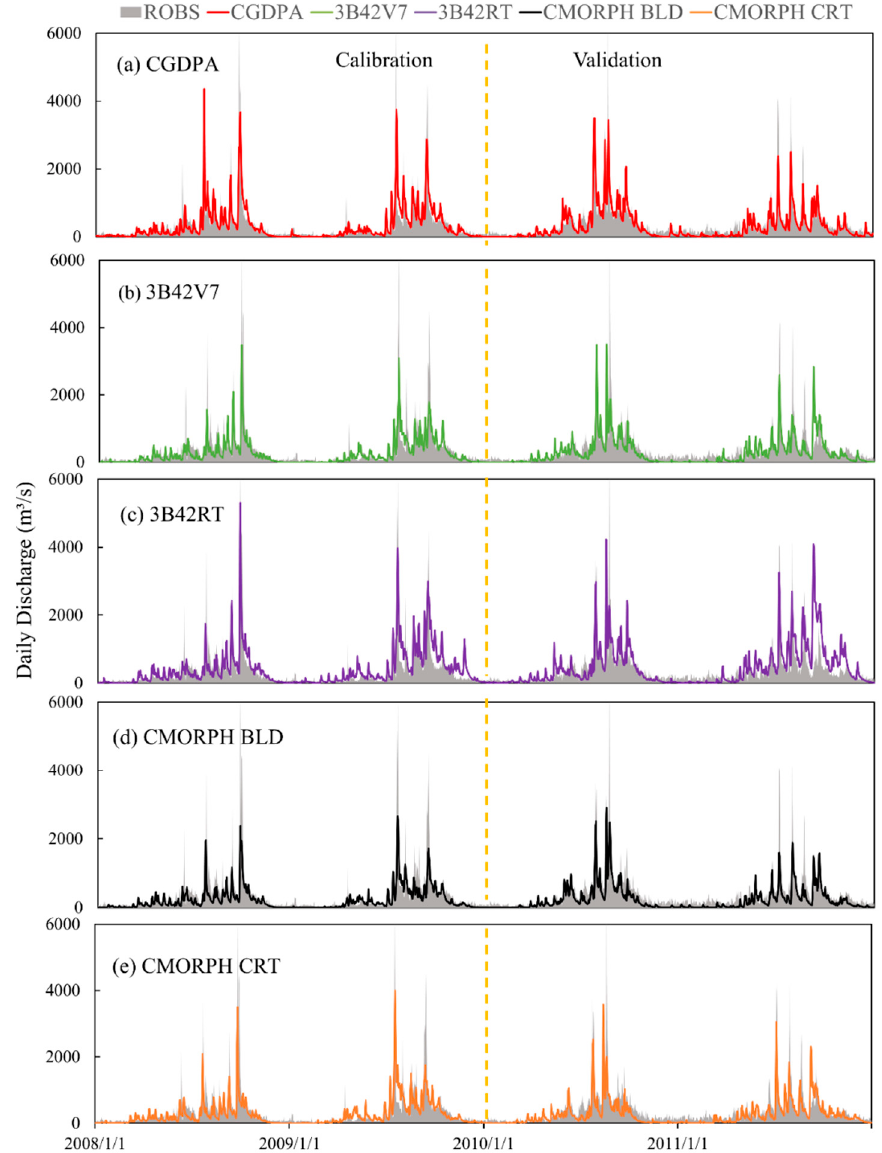
Figure 10. Comparison of observed and simulated daily discharge in Scenario I from ( a ) CGDPA, ( b ) 3B42V7, ( c ) 3B42RT, ( d ) CMORPH BLD and ( e ) CMORPH CRT in both calibration (2008–2009) and validation (2010–2011) periods.